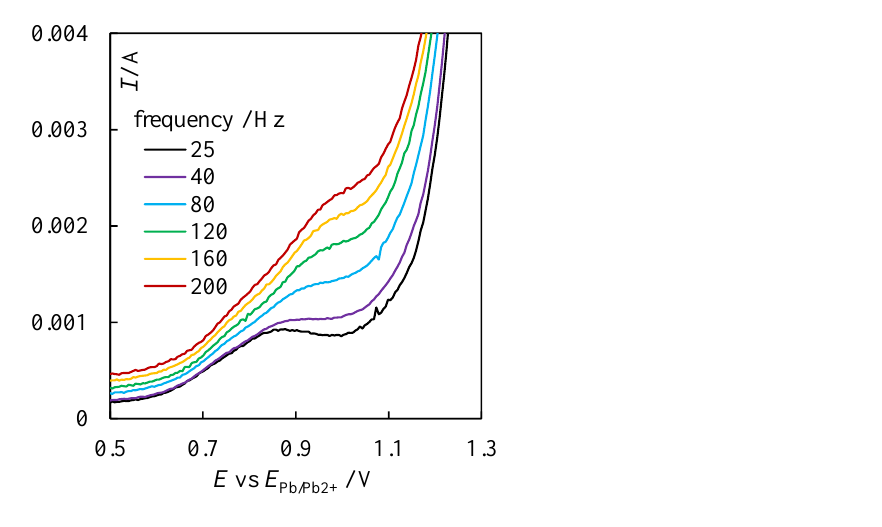
Figure 11. SWV in the PbCl 2 – 0.044 wt% PbO melt at a potential reverse frequency ranging from 25 to 200 Hz, amplitude 20 mV, and a temperature of 520 °C.